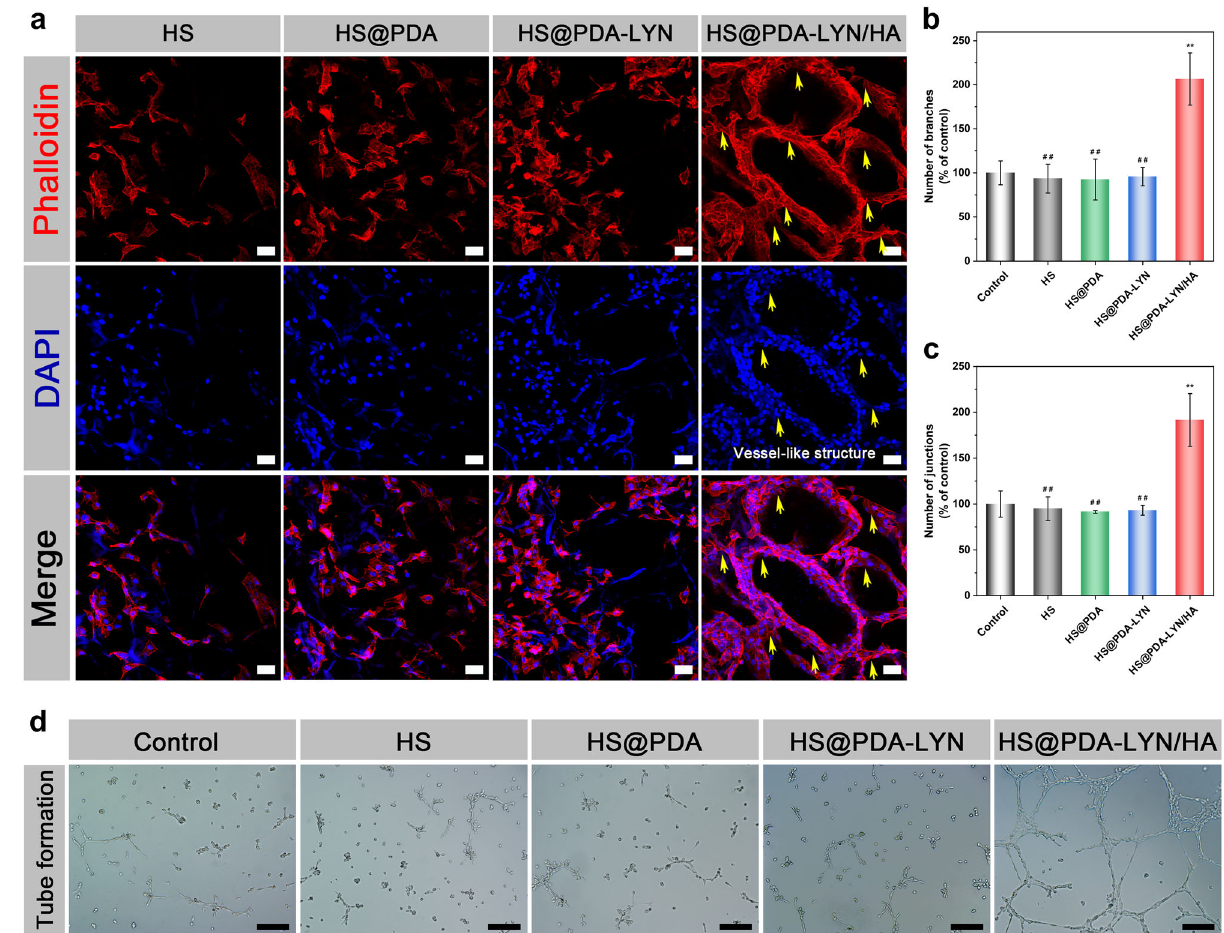
Fig. 7 In vitro angiogenic differentiation behaviors of HUVECs after different treatments. a Representative confocal fl uorescence images of F-actin (red) and nuclei (blue) in HUVECs cultured on different scaffolds for 14 days. The yellow arrows indicate the vessel-like structure. b – d Representative tube formation images for HUVECs incubated with different extract samples and quantitative analysis of the tube formation ability in different groups. Scale bar in a : 50 μ m, in d : 200 μ m. Data are expressed as the mean ± SD ( n = 3). * P < 0.05 and ** P < 0.01 indicate signi fi cant differences compared with the control group. # P < 0.05 and # # P < 0.01 indicate signi fi cant differences compared with the HS@PDA-LYN/HA